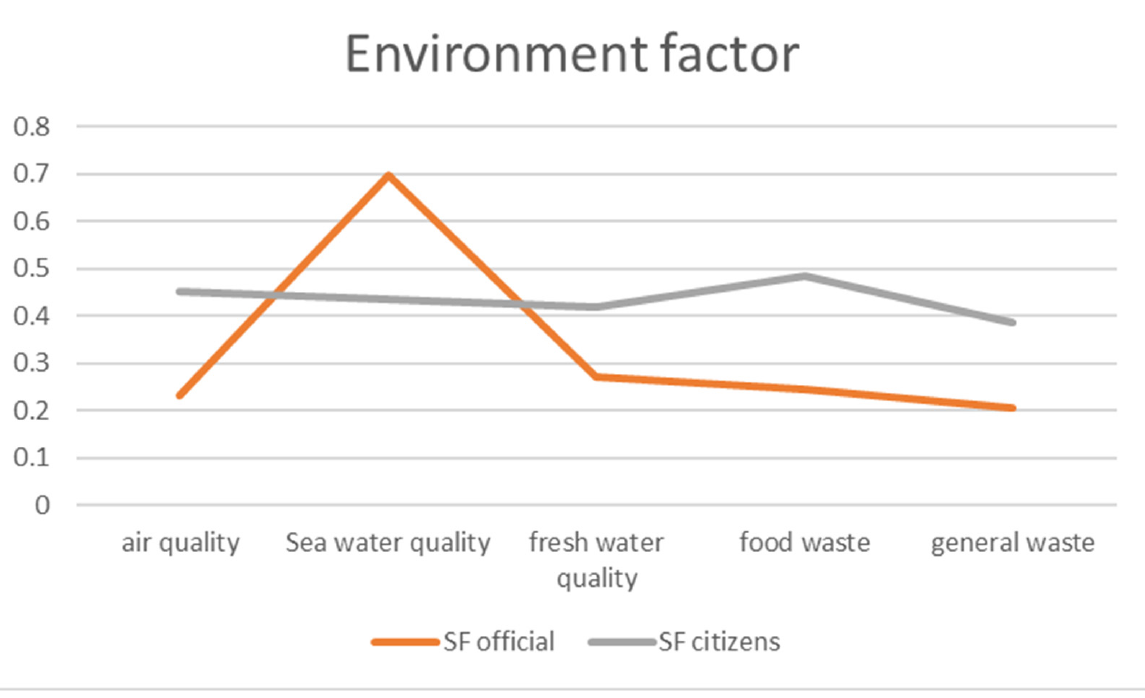
Figure 9. Analysis of environment activities by calculating the coefficient of the supportability fac- tor.